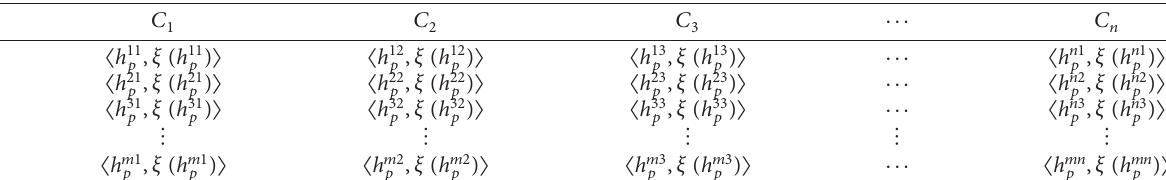
Table 4: Normal probabilistic hesitant fuzzy decision matrix.